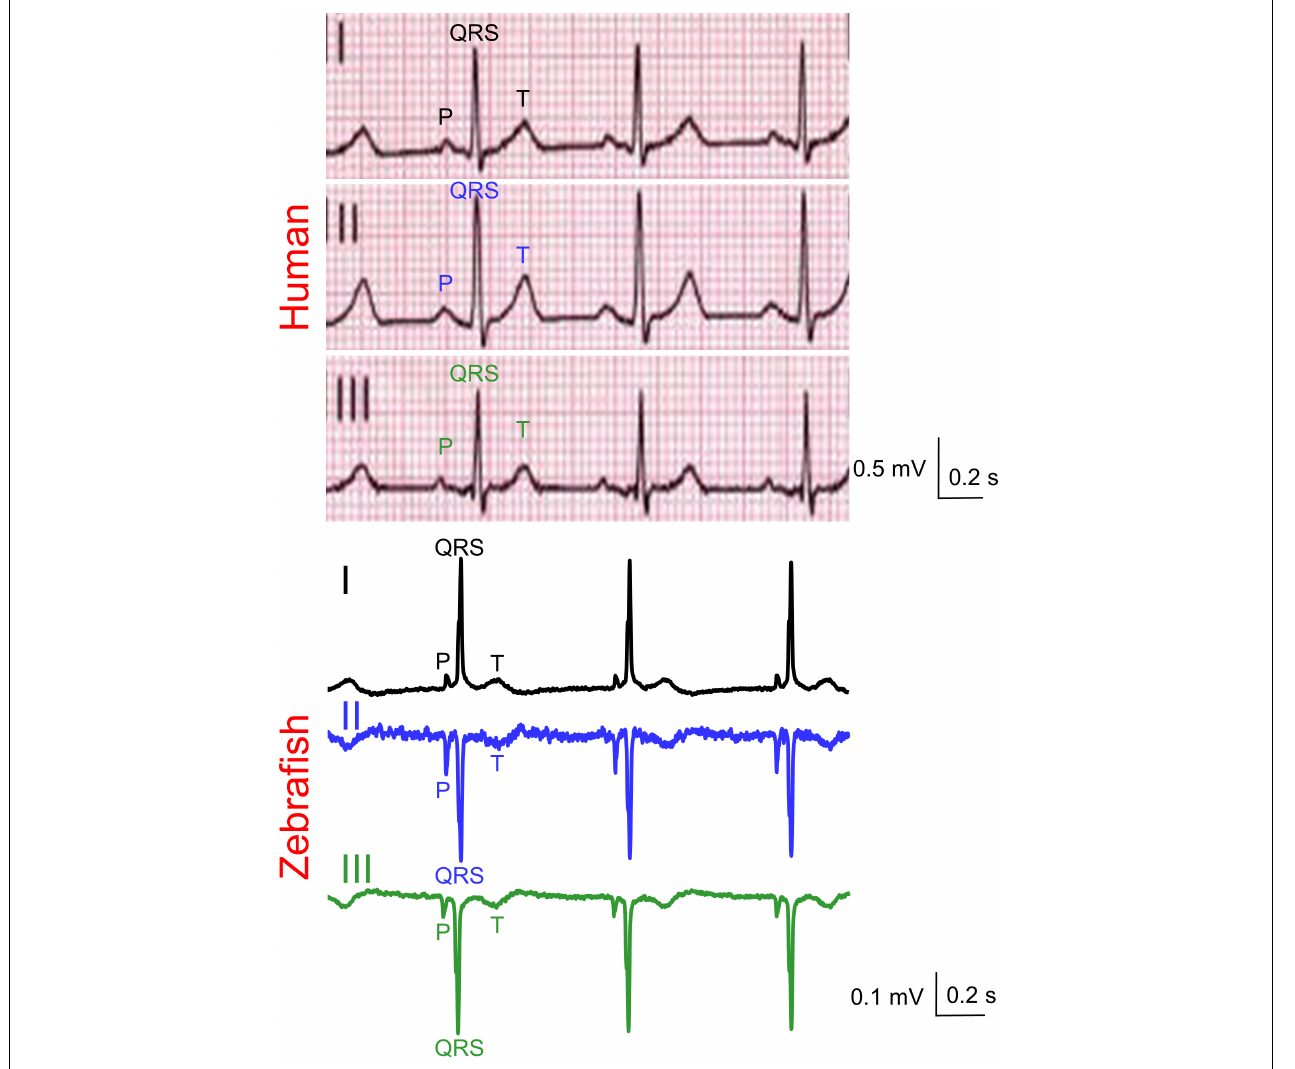
FIGURE 2 | Representative simultaneous Einthoven ECG recordings from an adult man and an adult male zebrafish. Zebrafish lead III was software-derived based on Einthoven’s Law (II = I +